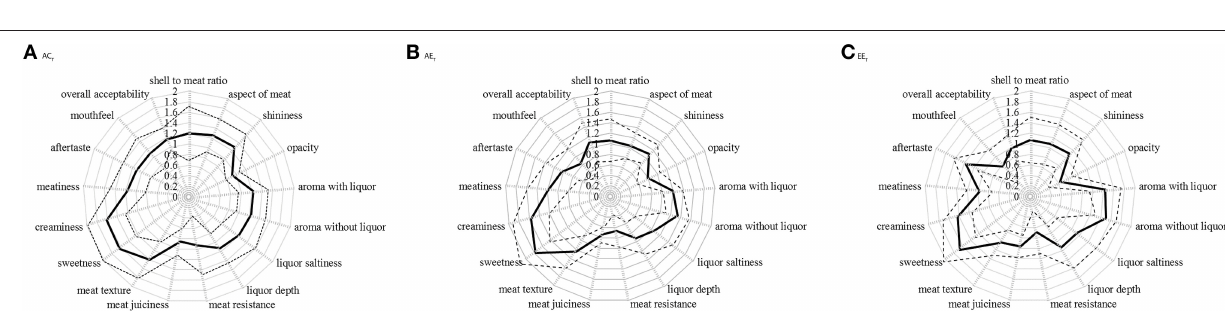
FIGURE 3 | Score attributed by the panelists to each of the 17 oyster attributes . (A) Ambient p CO 2 & control temperature (AC T ), (B) Ambient p CO 2 & elevated temperature (AE T ), (C) Elevated p CO 2 & elevated temperature (EE T ). Mean ( n = 9) scores (continuous line) with confidence interval (dotted lines), on scales ranging from 0 (optimum score) to 3 (least favorable